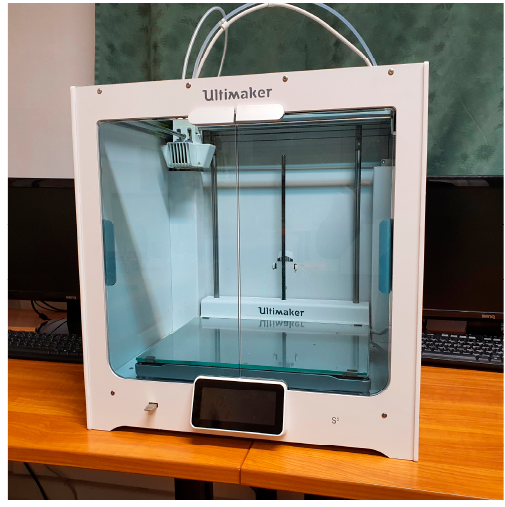
Figure 3. The applied Ultimaker 3D printer. Table 2. Characteristics of the applied Ultimaker 3D printer.